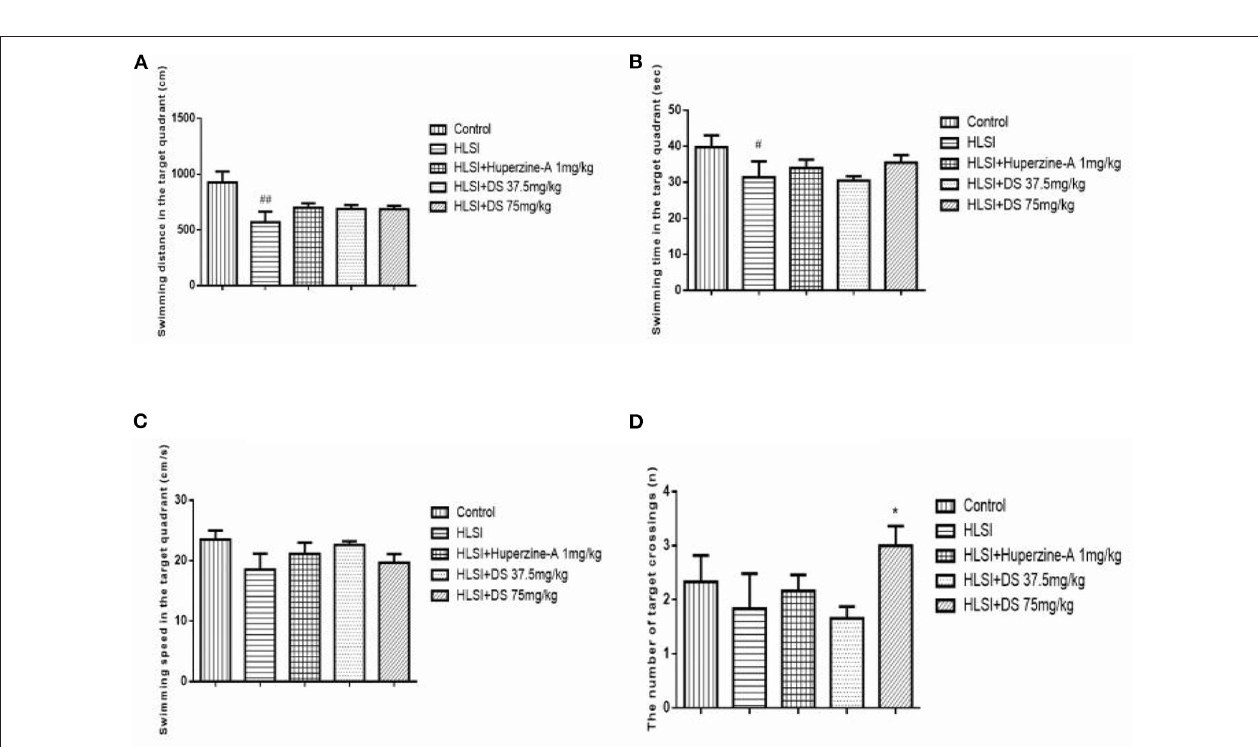
FIGURE 10 | The effect of DS on memory of rats in probe trial of the MWM test. All values are means ± SEM ( n = 7–8). In the target quadrant, parameters noted were as follows: (A) swimming time, (B) swimming distance, (C) swimming speed, and (D) the number of target crossings. The symbols represent: # p < 0.05 and ## p < 0.01 vs. the control group; * p < 0.05 vs. the HLSI group.